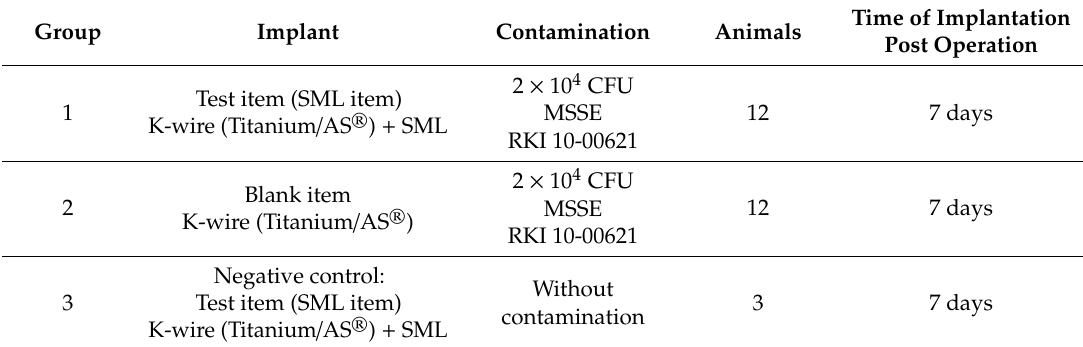
Table 1. Main study-group